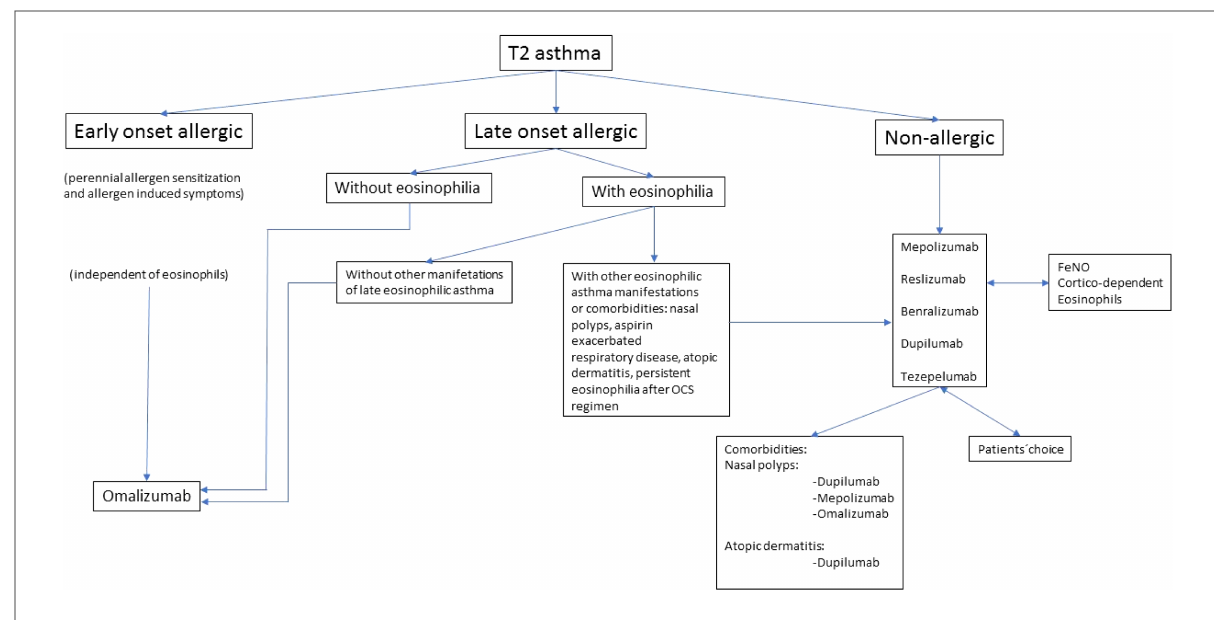
FIGURE 1 Algorithm to choose a monoclonal